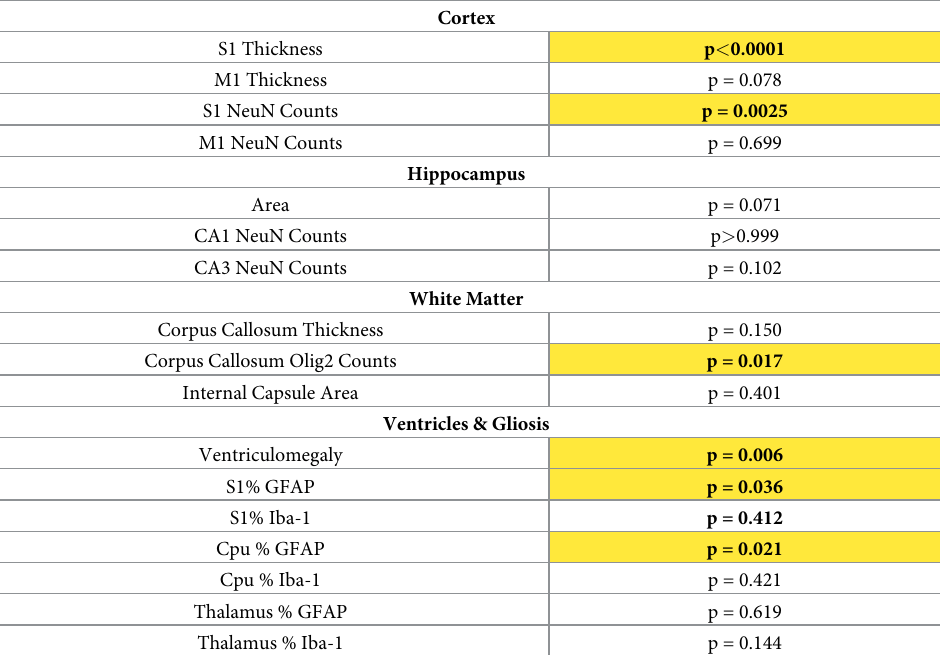
Table 1. Effect of genotype on HI Injury. All Sham animals showed no differences in all measured parameters across genotypes. KO injured animals displayed increased severity of injury in the S1, corpus callosum, ventricles, as well as significantly elevated astrogliosis in S1 and the CPu when compared to WT injured animals. Adjusted p-values for the KO injured and WT injured comparison are shown. Those highlighted in yellow were significantly different across the two